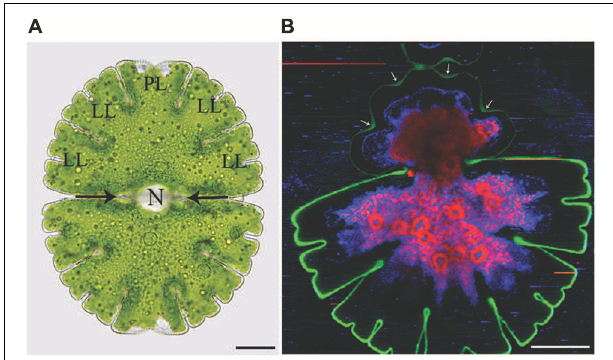
FIGURE 1 | Light microscopic (A) and Raman spectroscopic (B) image of Micrasterias denticulata. (A) The cell consists of two semicells that are connected by an isthmus (black arrows). Each semicell has one polar lobe (PL) and four denticulated lateral lobes (LL). The nucleus (N) is located in the cell center. (B) The different colors of the Raman image represent chemically different regions identified by non-negative matrix factorization. The green color represents the cellulosic cell wall which is more distinct and thicker in the non-growing old semicell, when compared to the newly formed young semicell (upper part). In the young growing semicell, the cell wall in the area of the indentations is highlighted more intensively (arrows) than at the lobe tips. Raman spectroscopic image kindly provided by Notburga